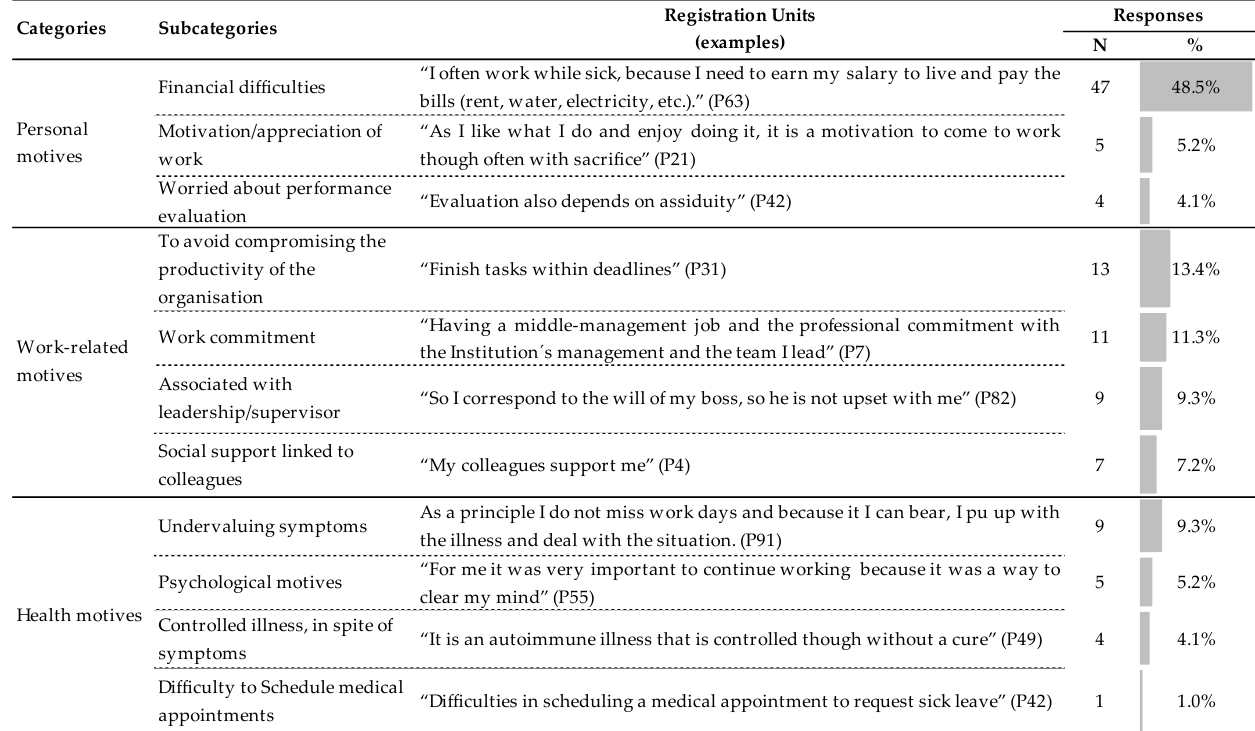
Figure 2. Categories, subcategories, registration units, and frequency of the Reasons for Presenteeism.